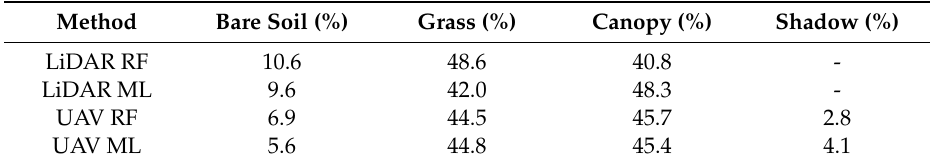
Table 2. Percentage area of canopy cover, grass cover and bare soil in areas under restoration process found through different image classification methods: UAV camera images classified with ML and RF algorithms, LiDAR images classified with ML and RF algorithms.